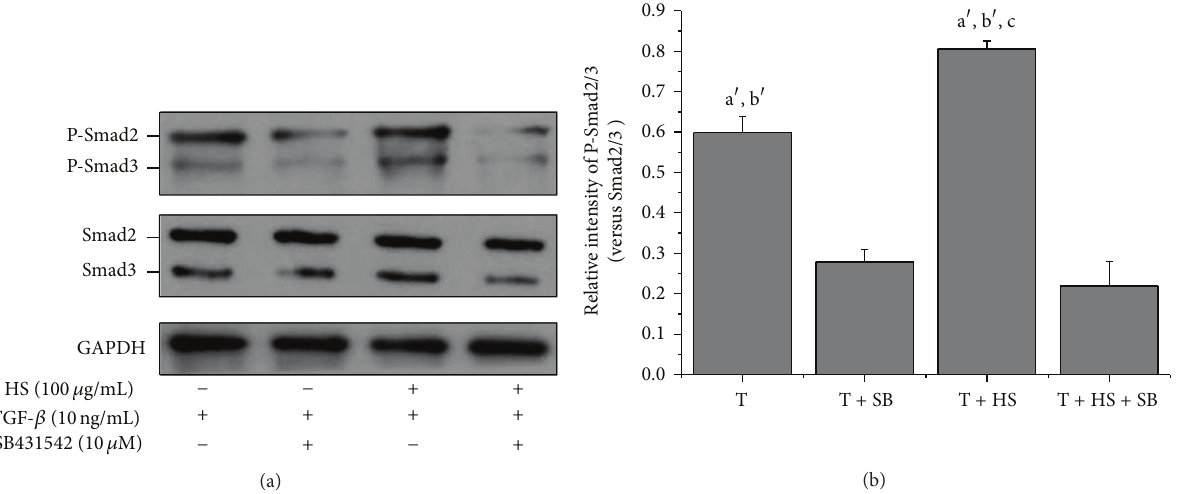
󸀠 𝑃 < 0.01 versus C group, b 𝑃 < 0.05 versus